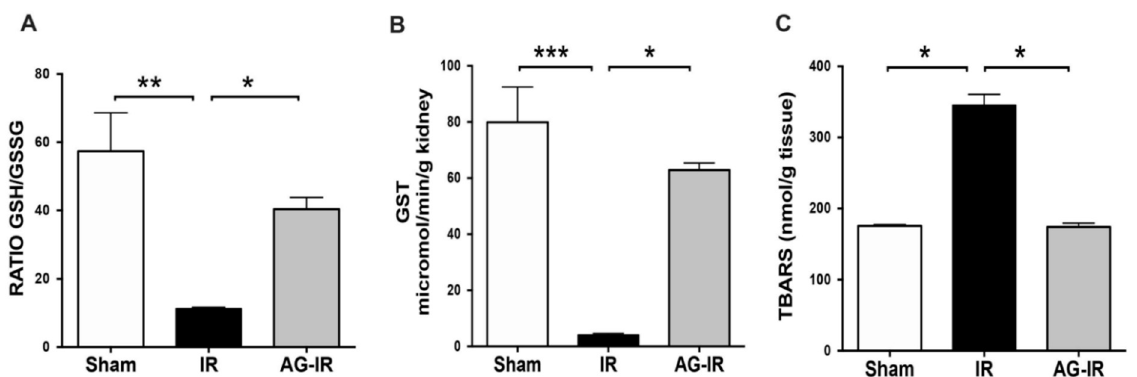
Figure 5. AG ameliorated the oxidative stress induced by renal IR. BALB/c mice were treated with either vehicle or AG (50 mg/kg i.p) before sham or IR surgery and subjected to 30 min of ischemia and 48 h of reperfusion. GSH:GSSG ratio, GST activity, and TBARS (lipoperoxidation) were determined in whole kidneys in sham (n = 5), IR (n = 5), and AG-IR (n = 6) ( A ) GSH:GSSG ratio. ( B ) Glutathione S-transferase (GST) activity. ( C ) Thiobarbituric acid reactive substances (TBARS) levels. Bar graph represents mean ± SEM, and data were analyzed by ANOVA non-parametric Kruskal–Wallis analysis, * p < 0.05, ** p < 0.005, *** p <